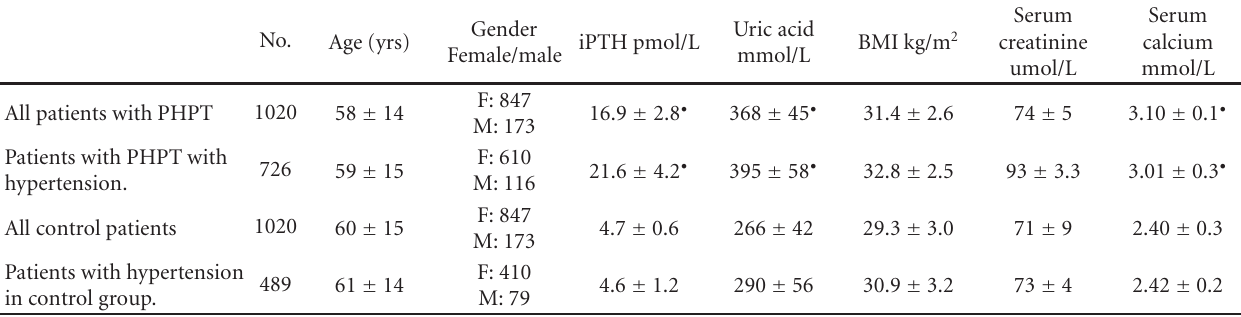
Table 1: Preoperative demographic, biochemical data and BMI in patients with primary hyperparathyroidism and controls. Results are presented as mean values ± SD. (cid:129) P < 0 . 01—patients with primary hyperparathyroidism versus controls.